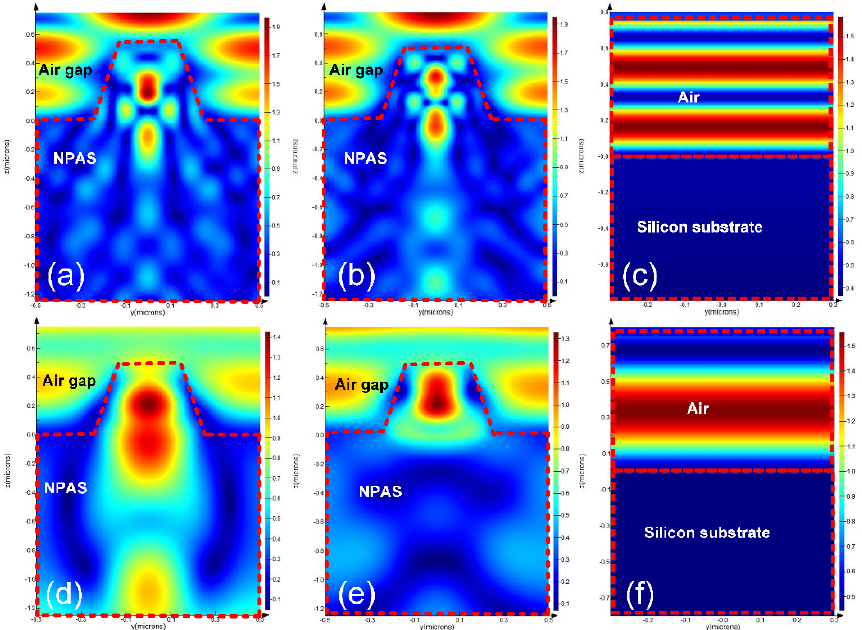
Figure 7. Electric field distribution under different conditions. ( a ) NPAS, ( b ) NPAS encapsulated by MoS 2 and ( c ) planar substrate at 660 nm incidence; ( d ) NPAS, ( e ) NPAS encapsulated by MoS 2 and ( f )planar substrate at 1350 nm incidence.